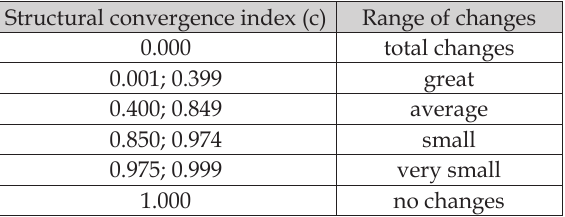
Table 1. Distinguished ranges of changes according to the value of the structural convergence index.